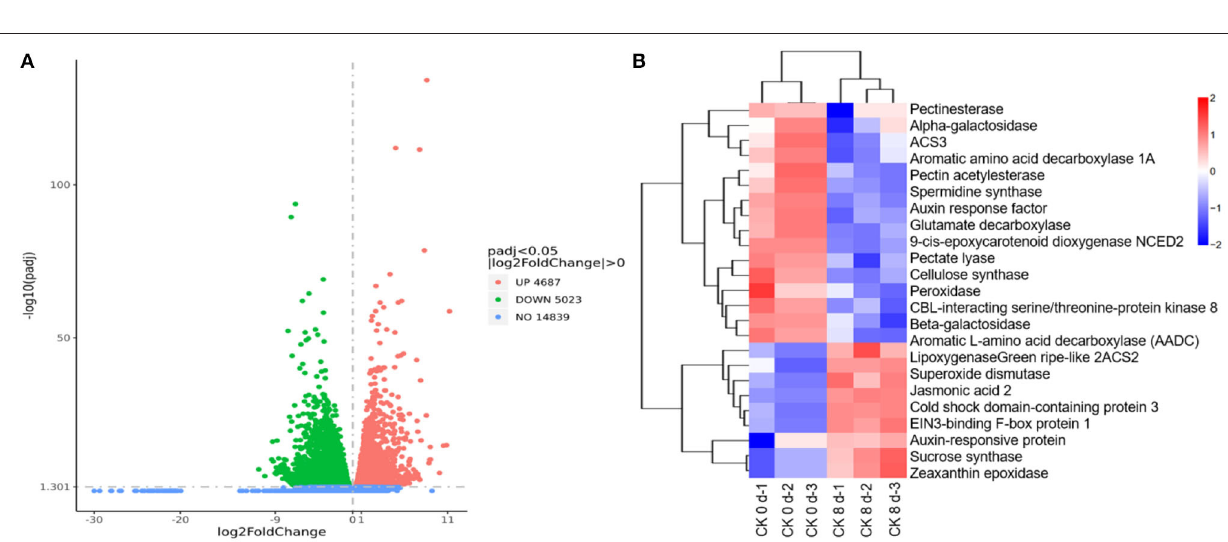
1-aminocyclopropane-1-carboxylate synthase 2 (ACS2) , 1- aminocyclopropane-1-carboxylate synthase 3 (ACS3) , auxin response factor (ARF) , auxin-responsive protein (AUX/IAA) , EIN3-binding F-box protein 1 (EBF1) , gibberellin